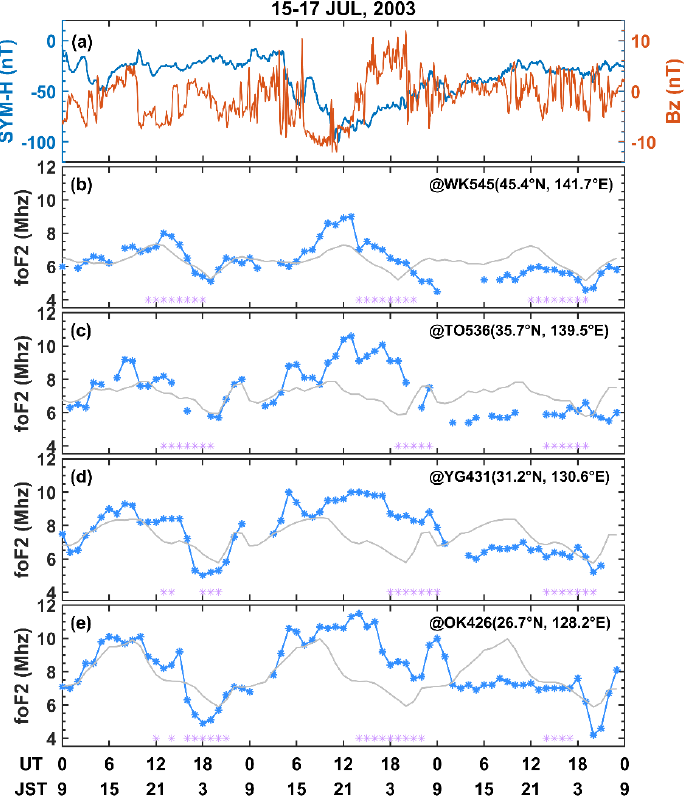
Figure 3. ( a ) The SYM-H (blue line) and IMF Bz (orange line) indices show geomagnetic storm development during the period 15–17 July 2003. Variations in the F2 layer critical frequency (foF2) at ( b ) WK545, ( c ) TO536, ( d ) YG431, and ( e ) OK426 during the period of 15 – 17 July 2003, as measured by ionosonde. Gray lines represent the 27-day moving average value as a reference. The light purple stars indicate the spread F obtained from ionograms. Note that JST = UT + 9.